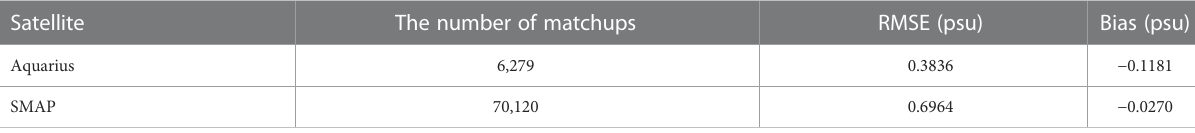
TABLE 2 Accuracies of satellite-observed sea surface salinity in the Northwest Paci fi c for Aquarius (2011 – 2015) and Soil Moisture Active Passive (SMAP) (2015 – 2020) by using matchup data with salinity data from Argo fl oats.